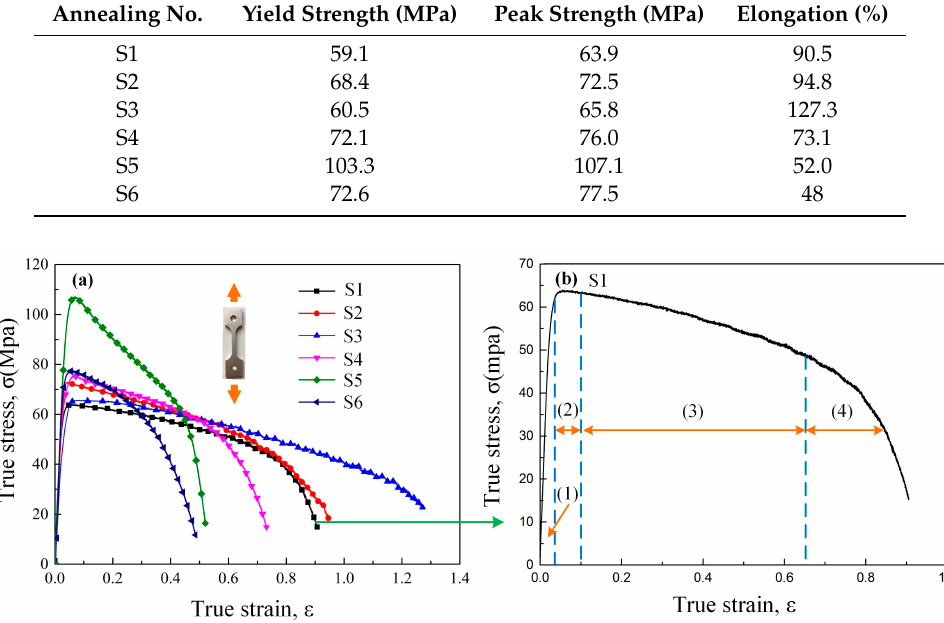
Table 4. The 900 ◦ C mechanical properties of TA17 with di ff erent microstructures. Table 4. The 900 °C mechanical properties of TA17 with different microstructures.